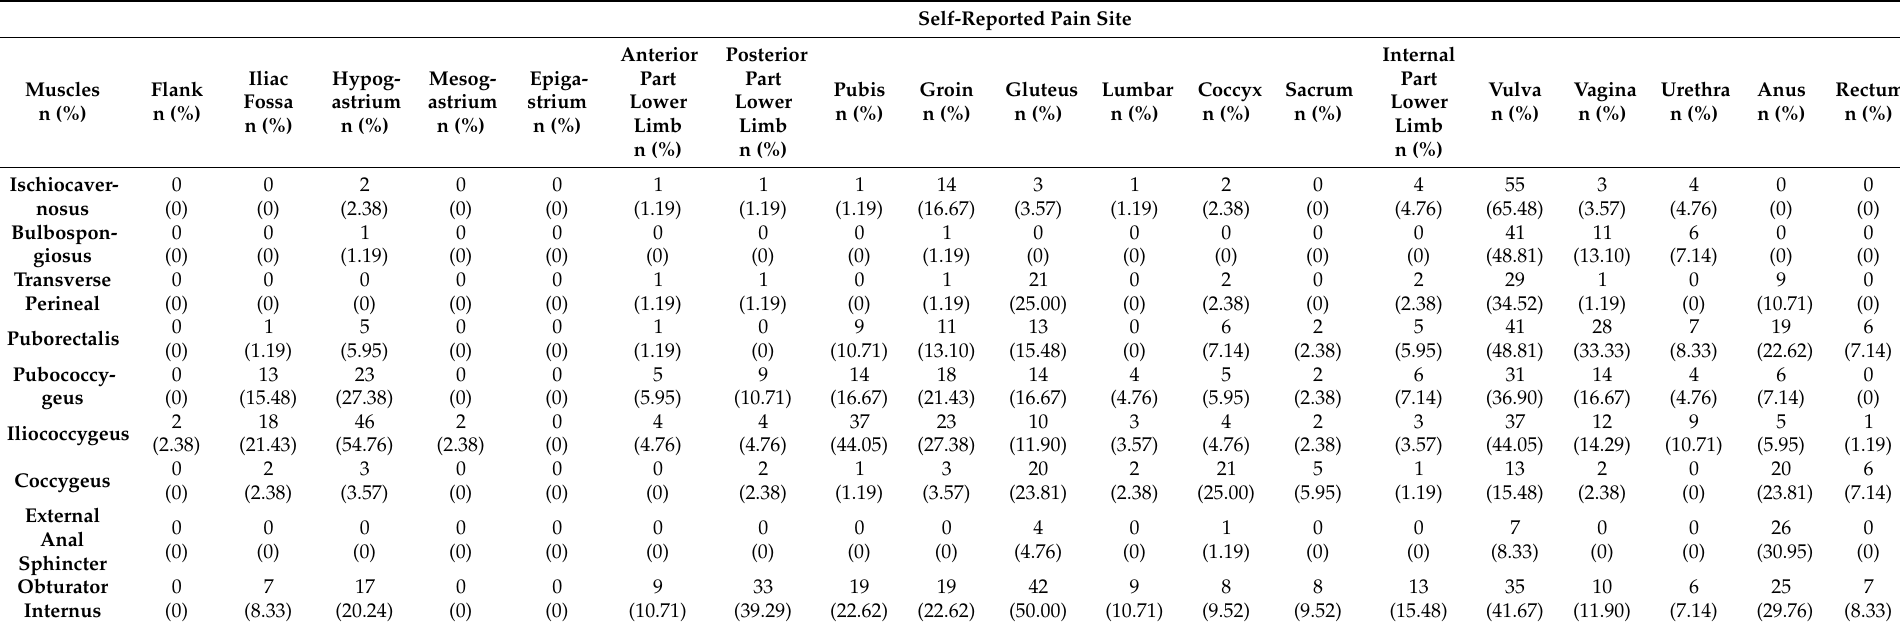
Table 11. Pain reproduced at specific sites after palpation in 84 participants during menstrual phase in the pelvic floor